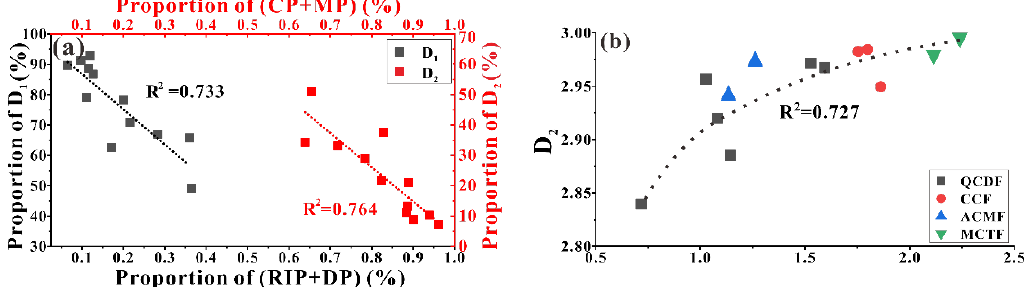
Figure 7. Plots exhibiting the relationships between ( a ) the proportion of different pore types and their fractal dimensions, and ( b ) D 1 and D 2 of different lithofacies.